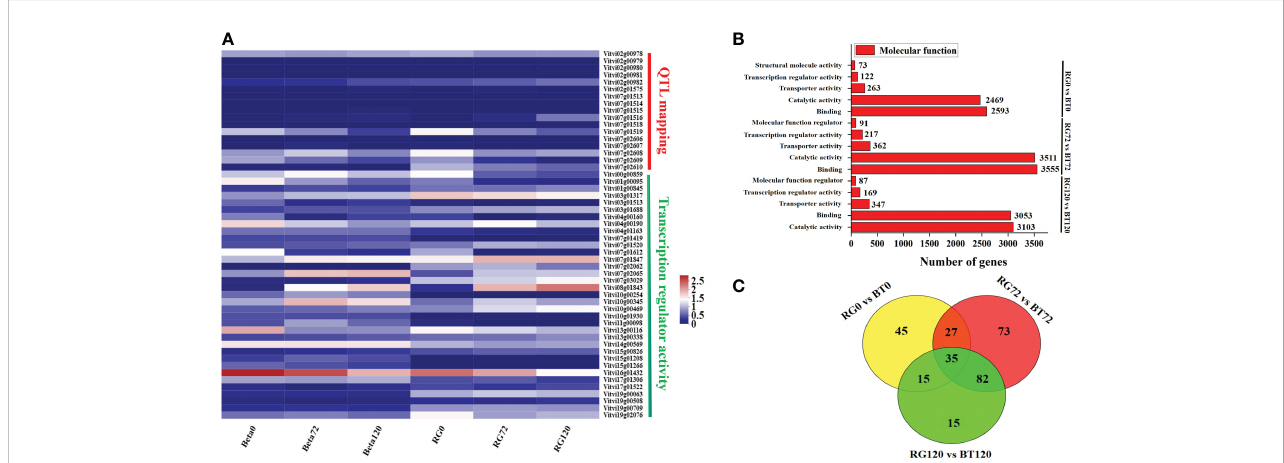
FIGURE 4 Differentially expressed structural gene and transcription factor analyses based on QTL mapping and GO enrichment. Analysis for grape cultivars ‘ RG ’ and ‘ BT ’ at different infection periods. (A) Cluster heat map of structural gene and transcription factor expression. (B) Number of differentially expressed genes in “ Molecular function ” catalog at different infection periods. (C) Common differentially expressed transcription factor identi fi cation in RG0 vs. BT0d, RG72 vs. BT72, and RG120 vs.